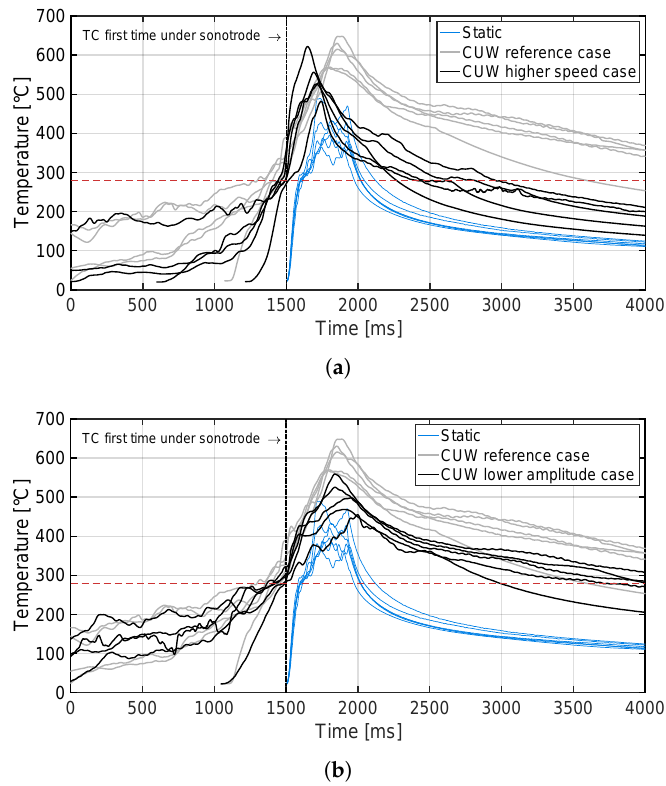
Figure 15. Combined interface temperature evolutions of the reference case (Figure 6a) of the continuous process, the static process (Figure 9a), and the temperature evolutions for ( a ) the higher welding speed case (65 mm/s) (Figure 6b), and ( b ) the lower amplitude case (70 µ m) (Figure 6c). The temperature evolutions were superimposed at the moment they were under the sonotrode for the first time. The red dashed line indicates the melting temperature of PPS as experimentally determined by DSC